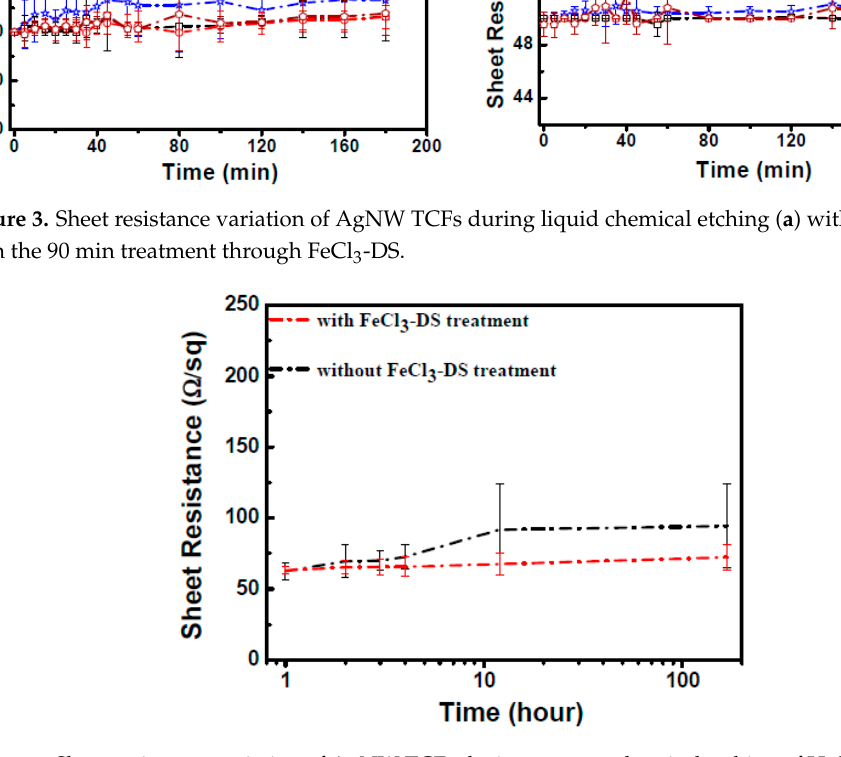
Figure 3 . Sheet resistance variation of AgNW TCFs during liquid chemical etching ( a ) without and ( b ) with the 90 min treatment through FeCl 3 -DS.